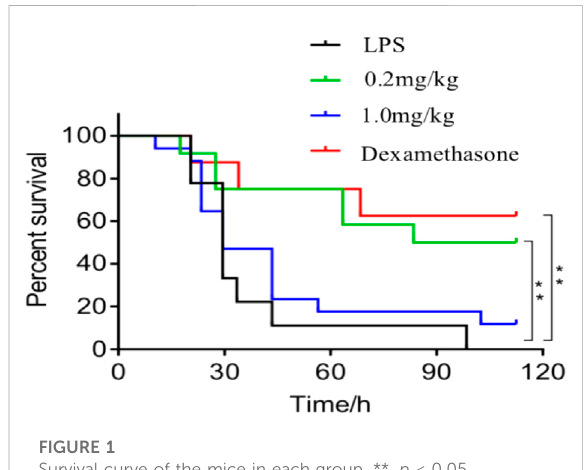
FIGURE 1 Survival curve of the mice in each group. **, p < 0.05, compared with model